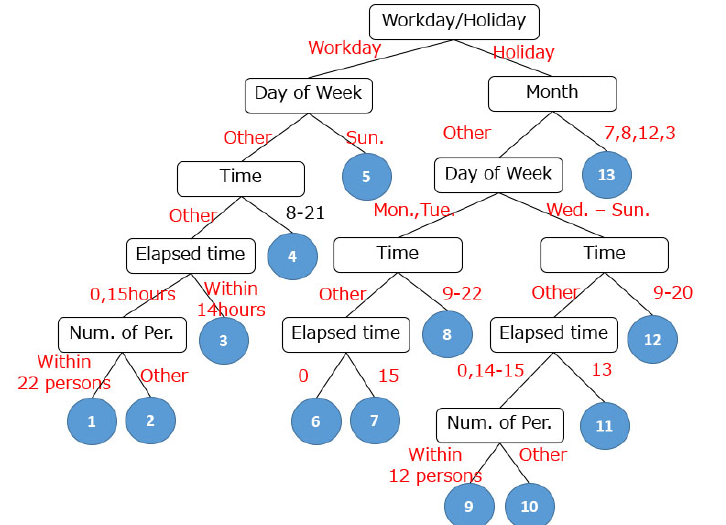
Figure 11. The prediction model for lights by the